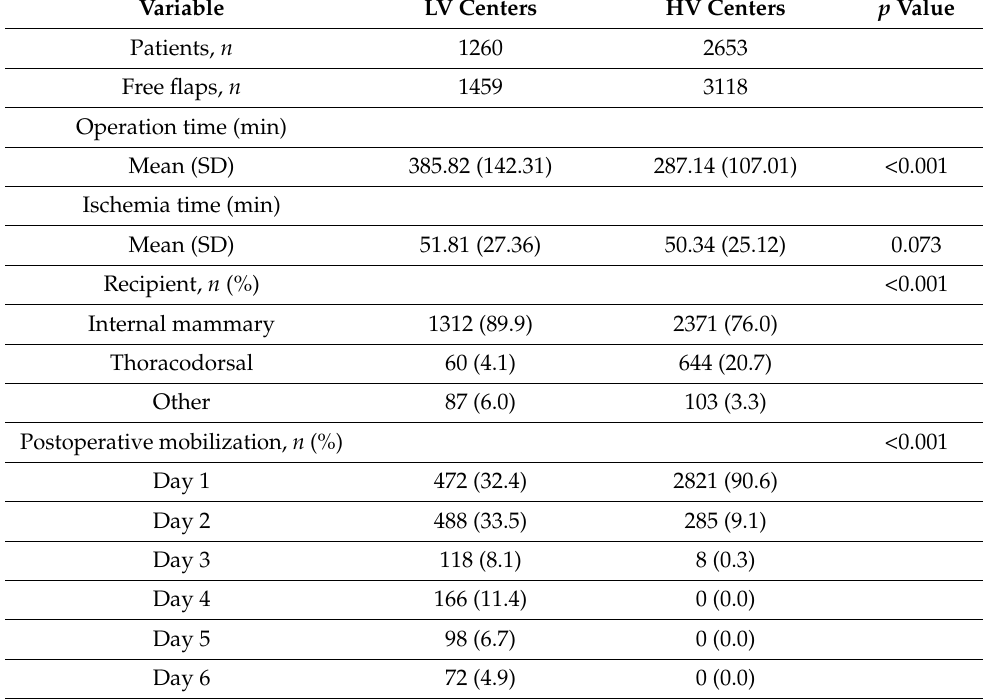
Table 5. Perioperative details according to the average number of DIEP flaps performed per year per center (high-volume group: ≥ Ø 40 DIEP flaps per year of data entry vs. low-volume group < Ø 40 DIEP flaps per year of data